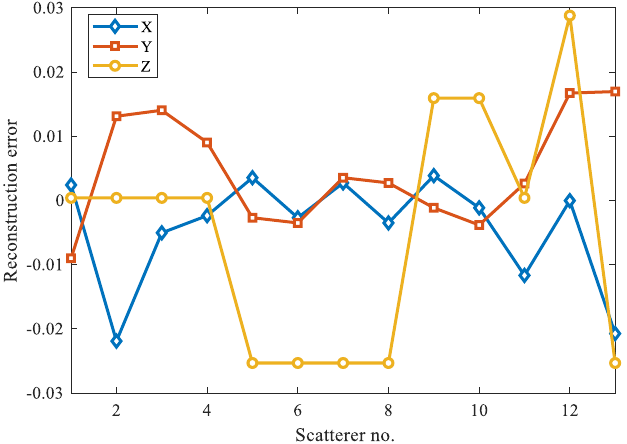
Figure 16. Reconstruction error of